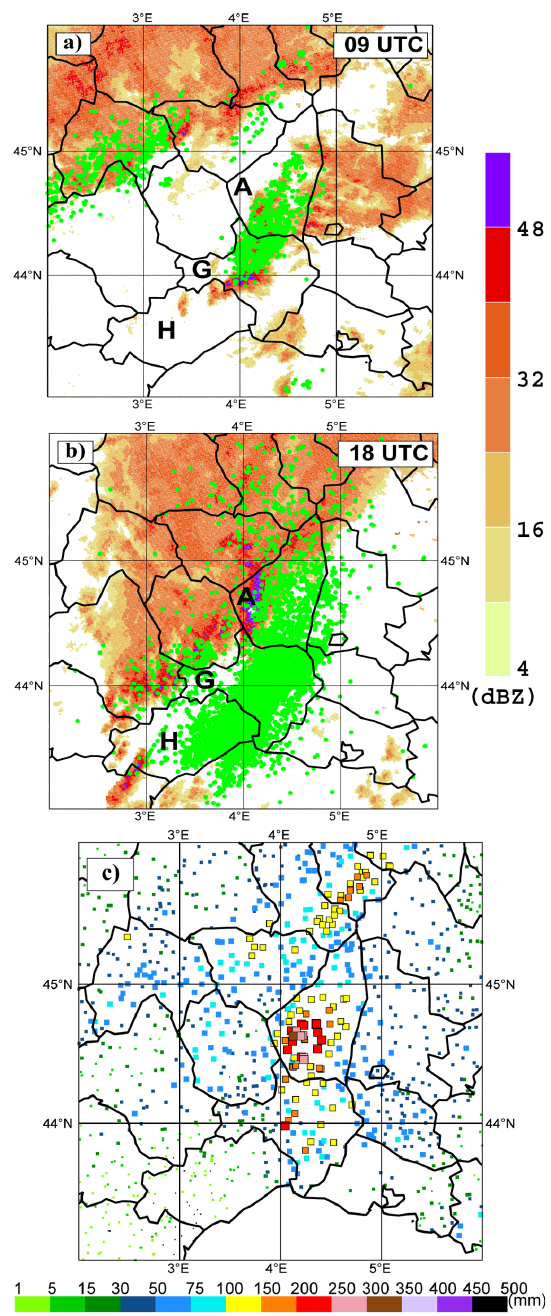
Fig. 4. Gard case radar reflectivities composite from the observa- tions on 7 September 2010 at (a) 09:00UTC, and (d) 18:00UTC, respectively. The green squares show lightning strikes observed dur- ing 3h from the radar time. The thin lines delineate the departments (administrative areas of France); the Bouches du Rh ˆ ones, the Var and the Alpes-Maritime departments are labelled B-R, V, and A-M, respectively. (c) stands for rainfall observations from